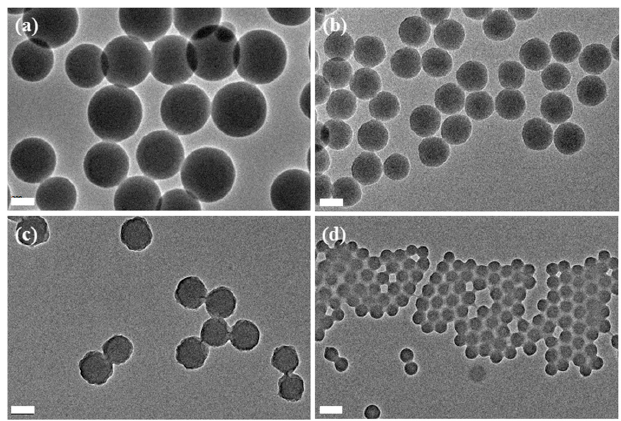
Figure 2. TEM images of PNAMAm with different amount of MBA as crosslinker: ( a ) 20%; ( b ) 30%; ( c ) 40%; ( d ) 50%. The scale bar is 200 nm.